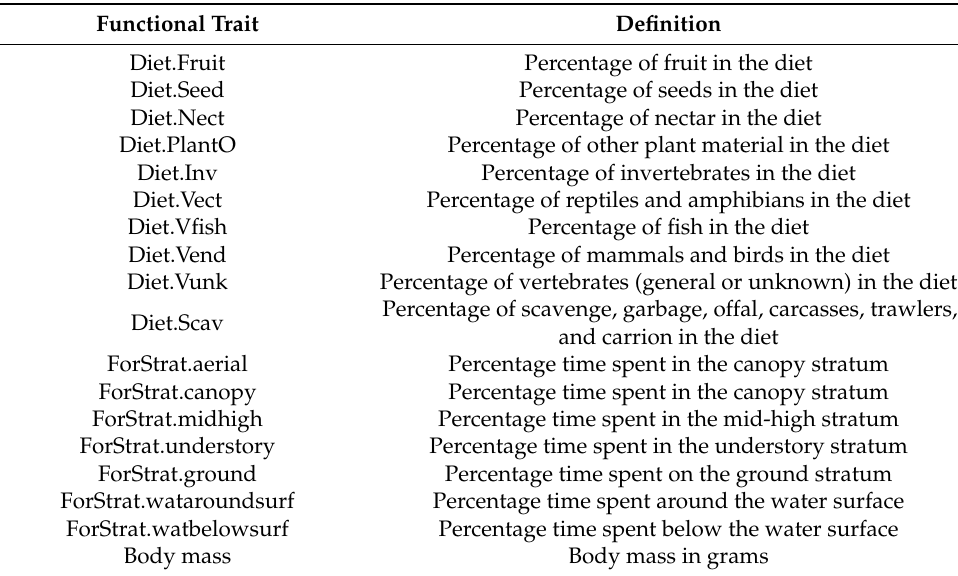
Table A2. List of functional traits for birds with